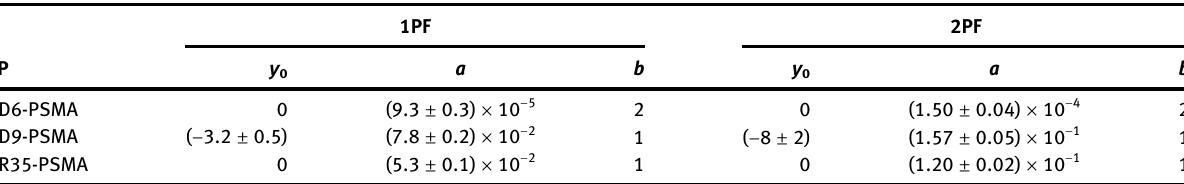
Table  : Fit parameters of the power laws performed on the data presented in Figure  , panels a through c.  PF  PF NP